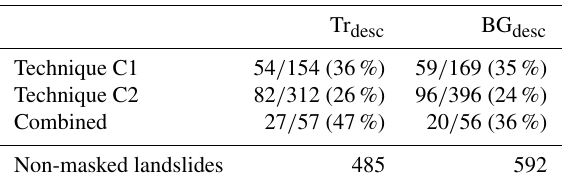
Table 3. The ratio of correct / assigned landslide timings for the two coherence-based